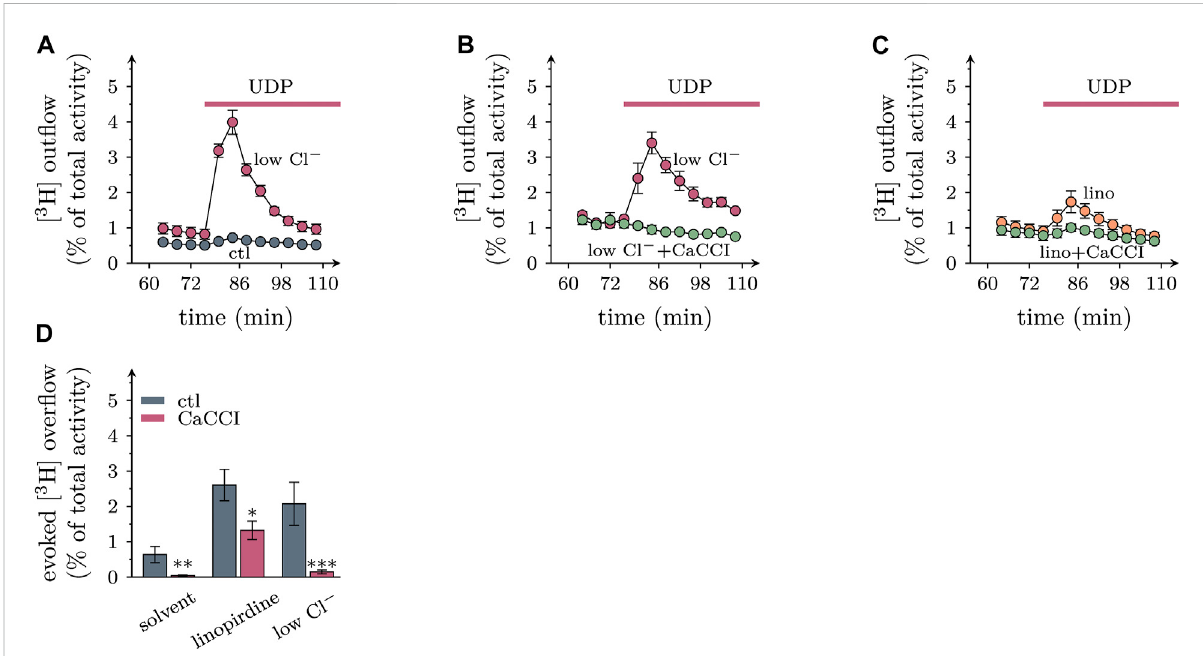
Roles of extracellular chloride and CaCCs in transmitter release from sympathetic neurons triggered by UDP. Primary cultures of rat SCG neurons were labeled with [ 3 H]noradrenaline and superfused; subsequent to a 60 min washout period, 4 min fractions of superfusate were collected; UDP was present as indicated by the arrows. (A) to (C) Exemplary time course of [ 3 H] out fl ow in solvent (DMSO), with 60 mM Cl − being replaced bygluconate(lowCl − ),and/orinpresenceof30 µMlinopirdineand/or10 µMCaCCInh-A01(CaCCI); n =3ineachtrace. (D) Effectsof CaCCInh-A01 (10 μ M; CaCCI) on [ 3 H] over fl ow triggered by UDP in solvent, in 30 µM linopirdine, and with 60 mM Cl − being replaced by gluconate (low Cl − ); n = 9 for each bar. *, **, and *** indicate signi fi cant differences vs the respective control at p < 0.05, p < 0.01, and p < 0.001, respectively (pairwise Mann-Whitney